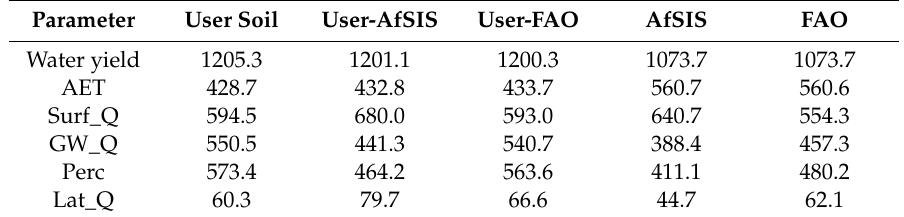
Table 5. Summary of simulated water balance components for di ff erent soil